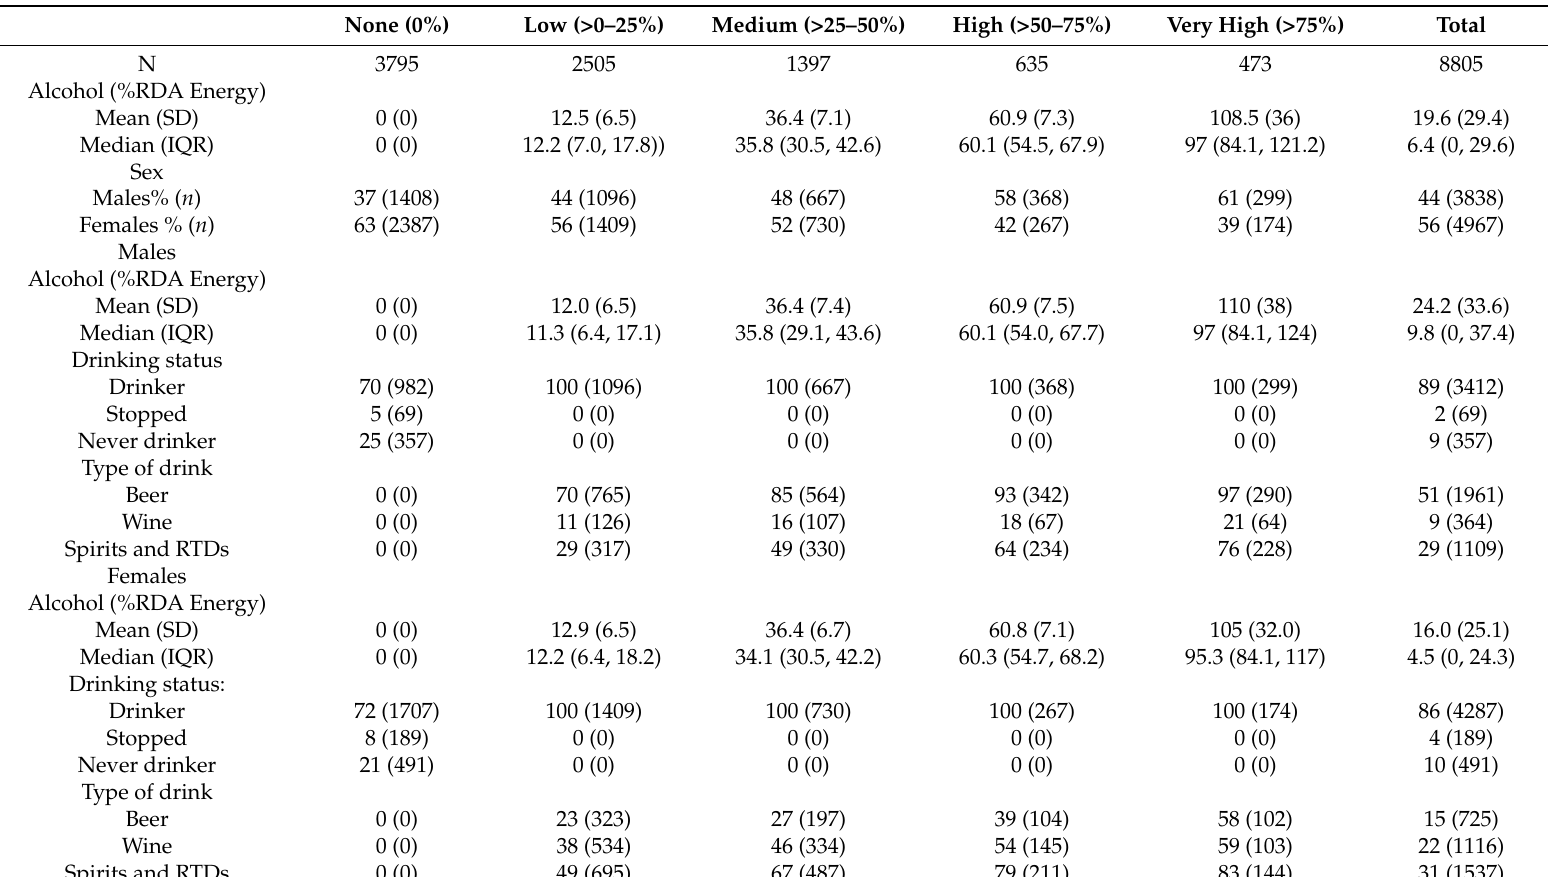
Table 2. Mean and Median Intake by percentage of recommended daily allowance for energy from alcoholic beverages consumed by individuals on their heaviest drinking day (% RDA energy), percentage of males and females in 18–25 year olds and percentage consuming different types of drink from the combined 2008–2014 Health Survey for England (HSE) and the Scottish Health Survey